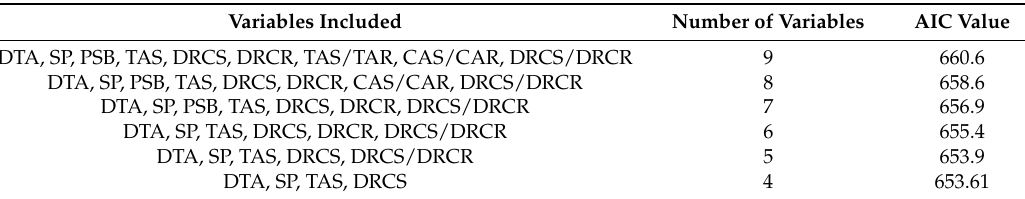
Table 9. Results of the stepwise procedure for selecting the variables to be included in the Cox proportional hazards model, in relation to the risk of death of